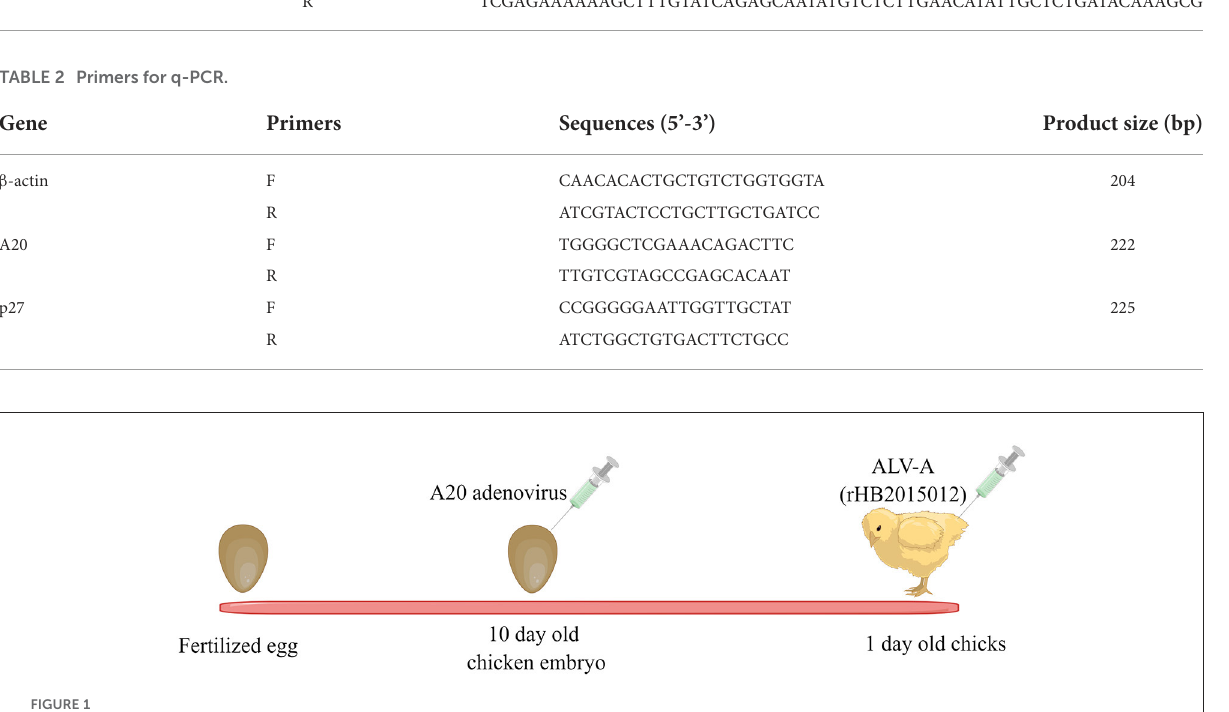
FIGURE1 A20 recombinant adenovirus and ALV-A vaccination schedule. Ten-day-old chicken embryos were inoculated with A20 recombinant adenovirus, and one-day-old chickens were inoculated with ALV-A.